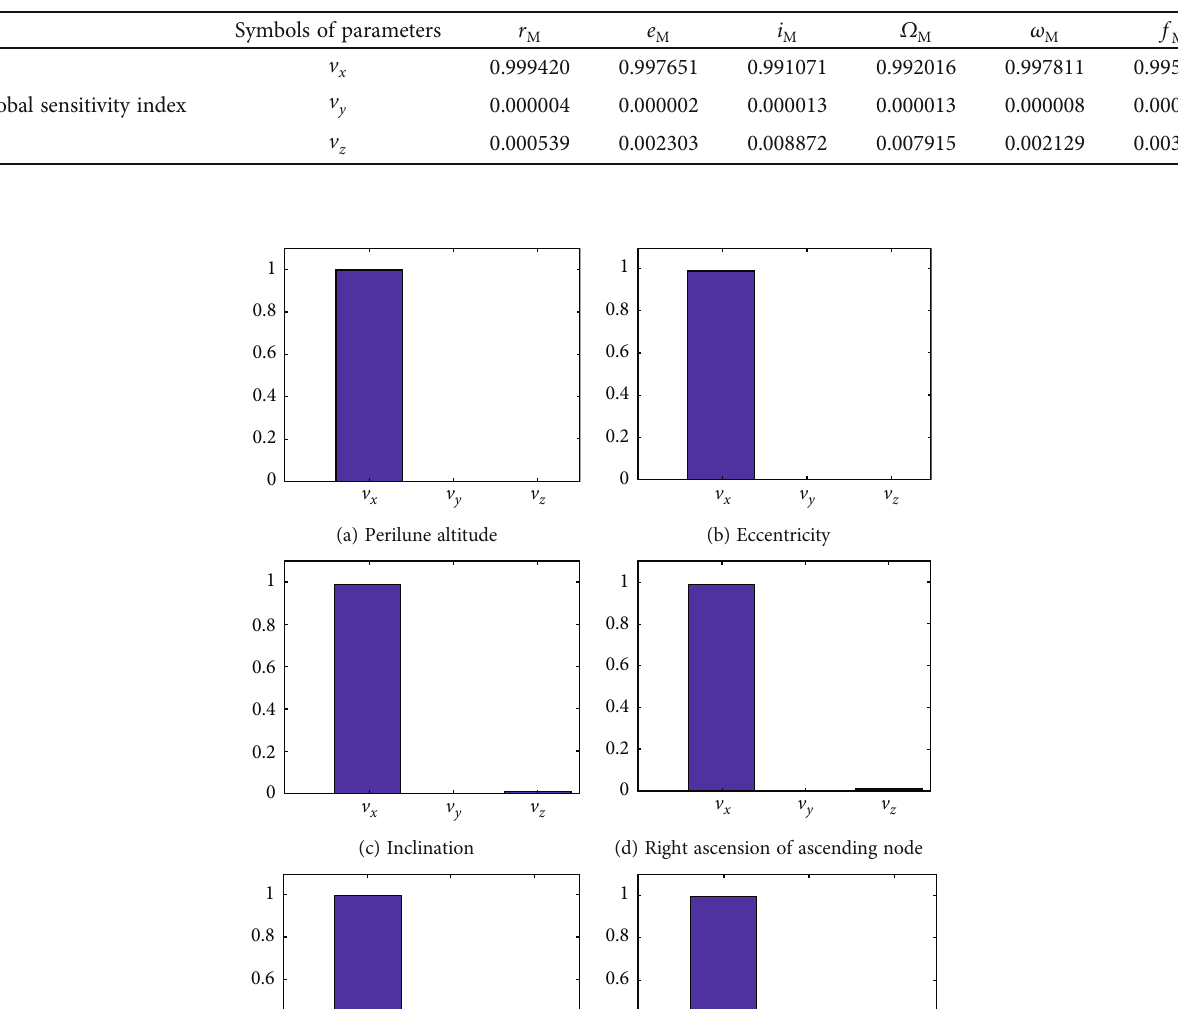
Table 6: Sensitivity index of velocity parameters.